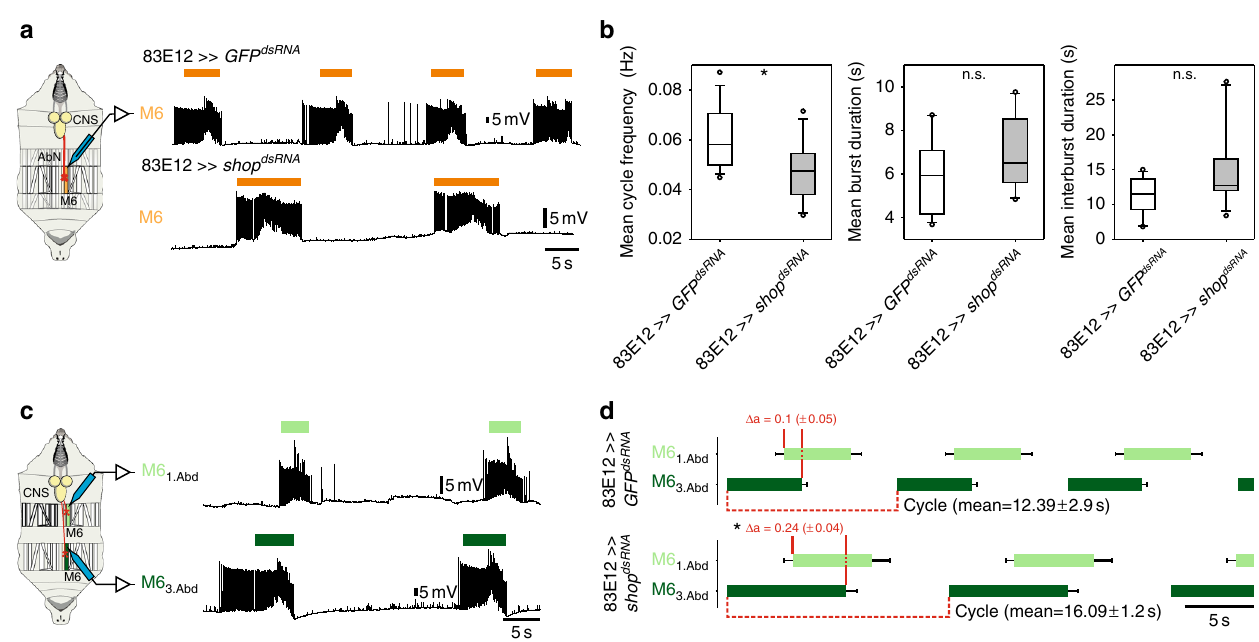
Fig. 3 Suppression of shopper impairs motor patterns underlying larval locomotion. a Experimental setup for single M6 intracellular muscle recordings of third-instar larvae; representative M6 recordings of ( UAS-GFP dsRNA ; R83E12-Gal4 ) (control, n = 15 animals) and ( UAS-shop dsRNA ; R83E12-Gal4 ) (n = 11 animals); orange bars indicate M6 bursts. b Box plots show the cycle frequency, burst duration, and inter-burst duration. Knockdown of shopper in the glial cells signi fi cantly decreased the cycle frequency compared to the control ( UAS-GFP dsRNA ; R83E12-Gal4 ). Box plots comprise the 25 – 75% coincidence interval, as well as the median. Whiskers comprise the 90% coincidence interval. Outliers are black dots. c Experimental setup for double M6 intracellular muscle recording of the fi rst and third abdominal segment in a third-instar larva. Representative M6 double recording of ( UAS-GFP dsRNA ; R83E12-Gal4 ) (Control); M6 motor activity of the third (dark green bars) and the fi rst (light green bars) abdominal segment resembles fi ctive forward crawling. d Motor pattern of ( UAS-GFP dsRNA ; R83E12-Gal4 ) (control, n = 12 animals) and ( UAS-shop dsRNA ; R83E12-Gal4 ) ( n = 7 animals) while forward crawling. Horizontal box plots represent mean M6 burst activity of fi rst (light green) and third abdominal segment (dark green), whiskers resemble the standard error of M6 burst activity. Dark green boxes represent the time until onset of the next burst in the same segment. This represents the cycle duration. Light green boxes represent the onset and offsets of bursts in the fi rst abdominal segment. Comparing offset of bursts in third abdominal segment with the onset of bursts in the fi rst abdominal segments reveals the phase delay Δ a, which is a measure for coordination of the wave of bursts which activates fi ctive crawling. In addition to the impaired crawling cycle of ( UAS-shop dsRNA ; R83E12-Gal4 ), the phase delay ( Δ a) between offset of motor activity in third abdominal segment and onset of motor activity in the fi rst abdominal segment shows signi fi cant difference indicating that coordination of the two abdominal segments is slightly impaired during crawling; * p < 0.05, n.s.: not signi fi cant, Mann – Whitney test ( b ) and two-tailed t -test ( d